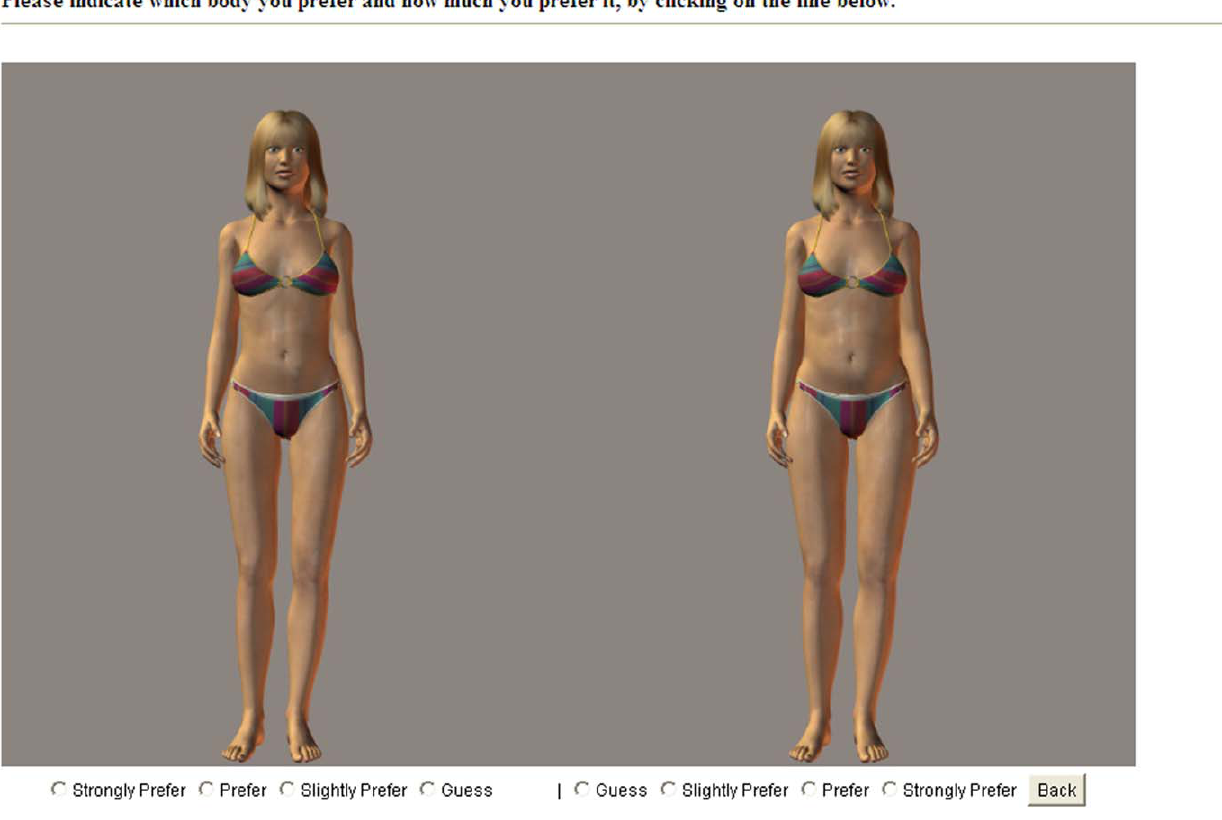
Figure 1. Example frame from the body size preference task.